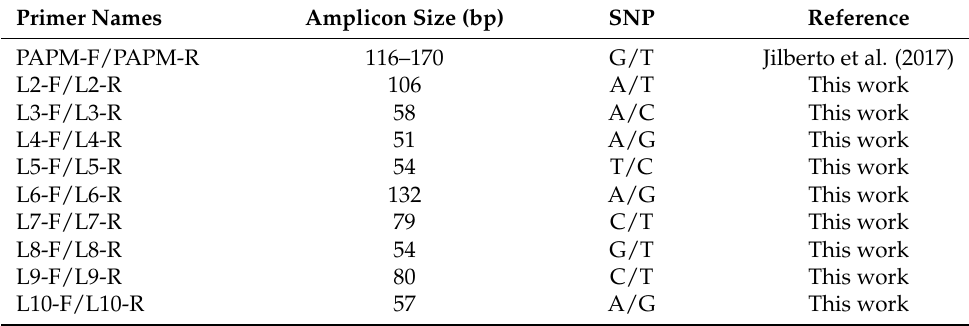
Table 2. Primer name, amplicon size, polymorphism and reference.